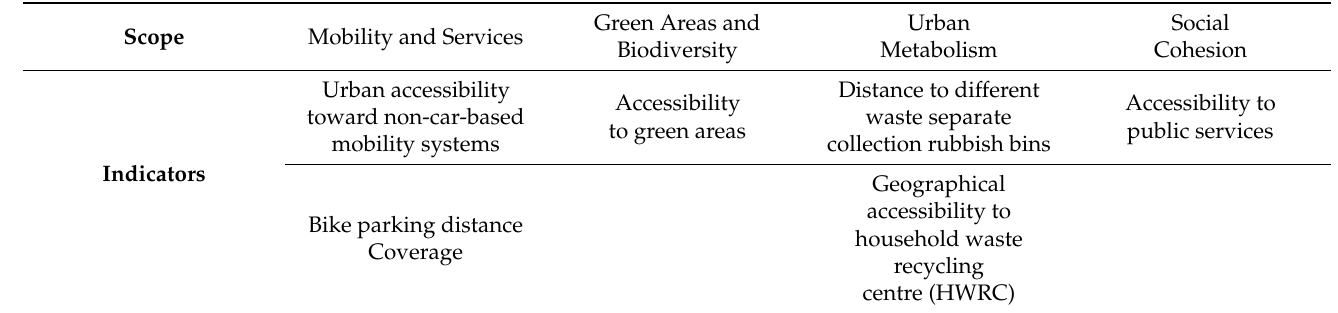
Table 2. Analysed indicators (source: System of Indicators and Conditions for large and middle-sized cities).